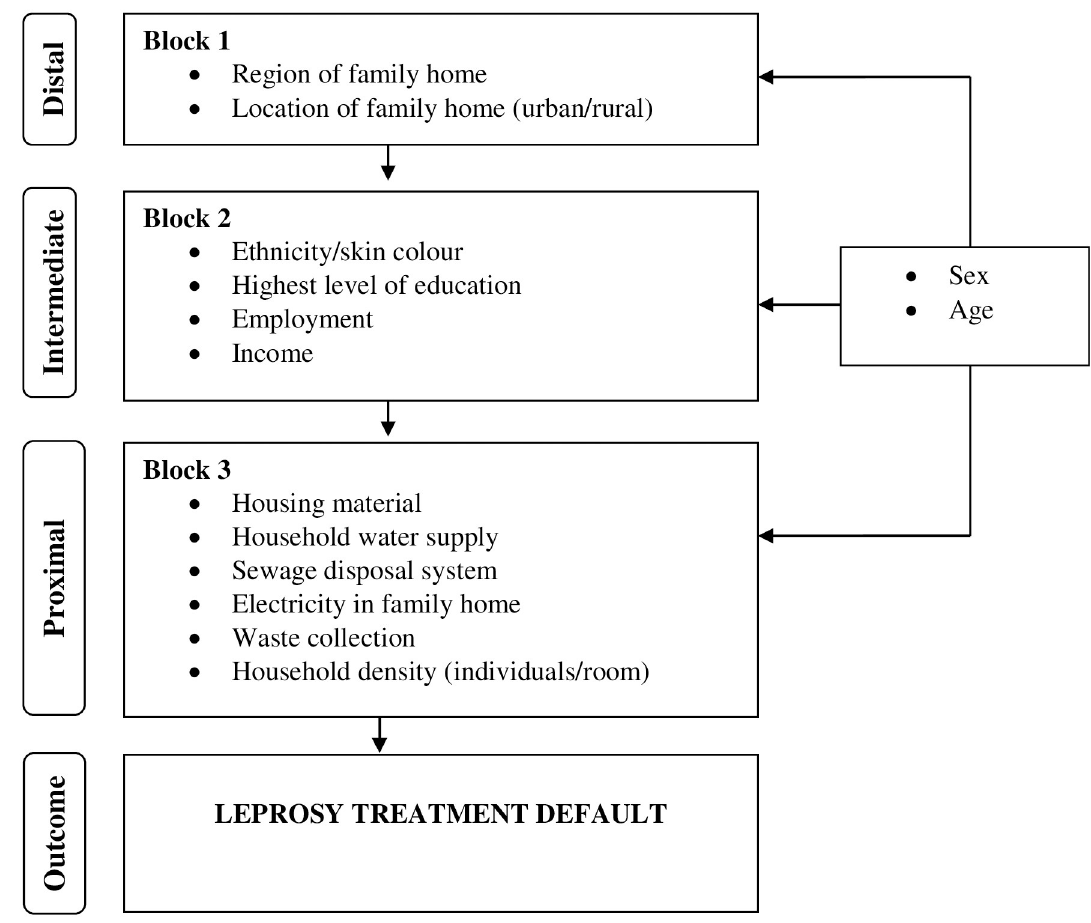
Fig 2. Hierarchical model for assessing geographic and socioeconomic factors associated with leprosy treatment default in